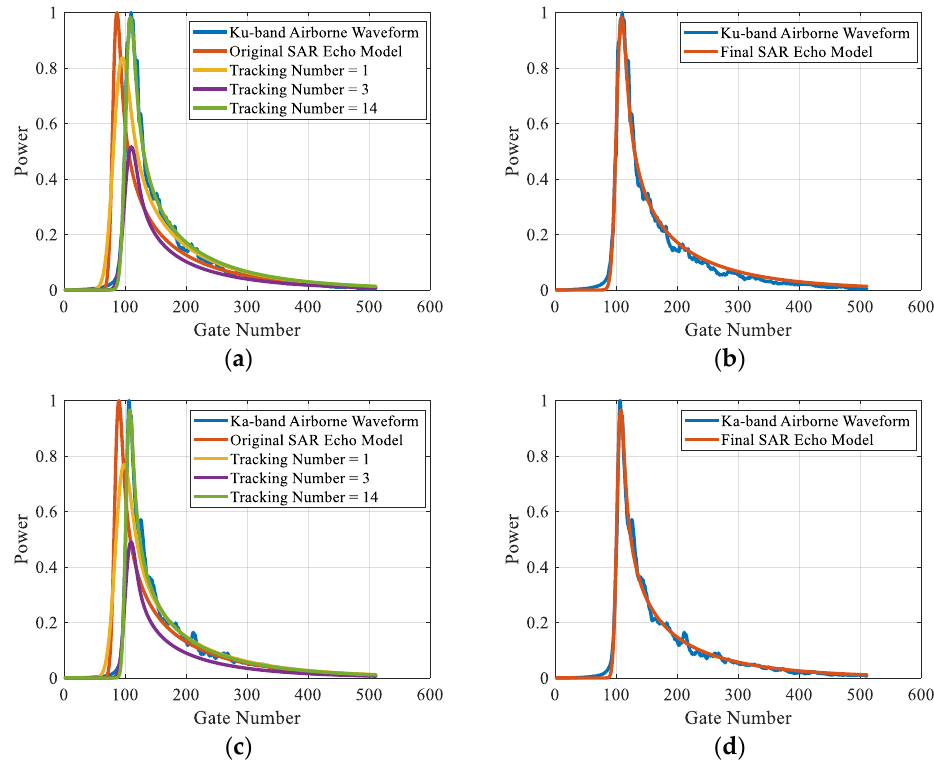
Remote Sens. 2022 , 14 , x FOR PEER REVIEW Figure 11. The waveform re-tracking iteration and result of Ku-band ( a , b ) and Ka-band ( c , d ).